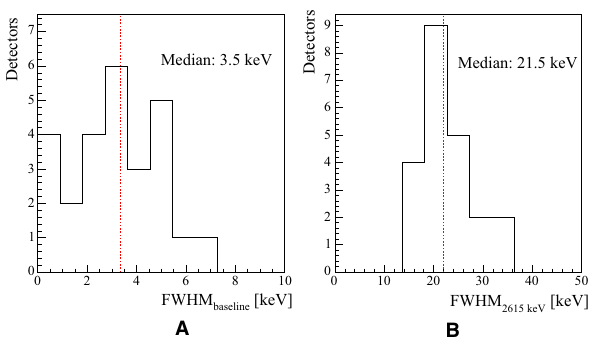
Fig. 25 Distribution of the ZnSe energy resolutions. The FHWM reso- lution at 0 keV, which is defined as the detector baseline noise, in shown in ( a ). While the distribution for the 2615 keV γ -line energy is shown in ( b )